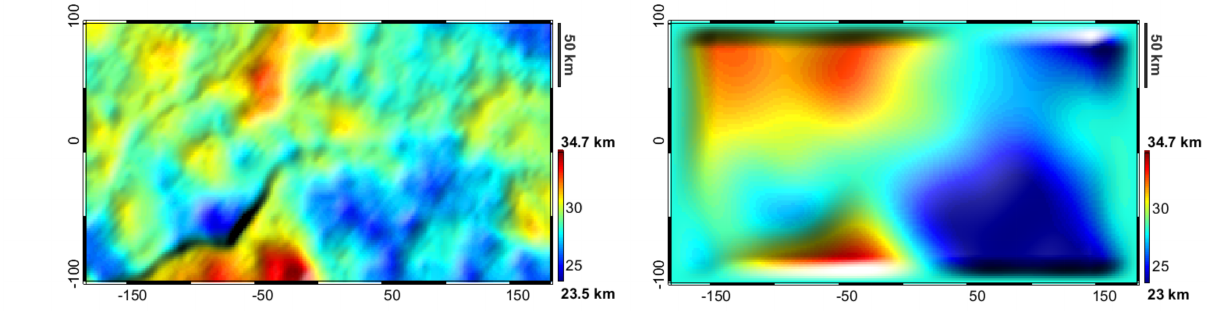
Figure 4. Two-layer problem inversion: Residuals between the gravitational effect of the true and a priori model ( left ) and of the true and the a posteriori model ( right ).